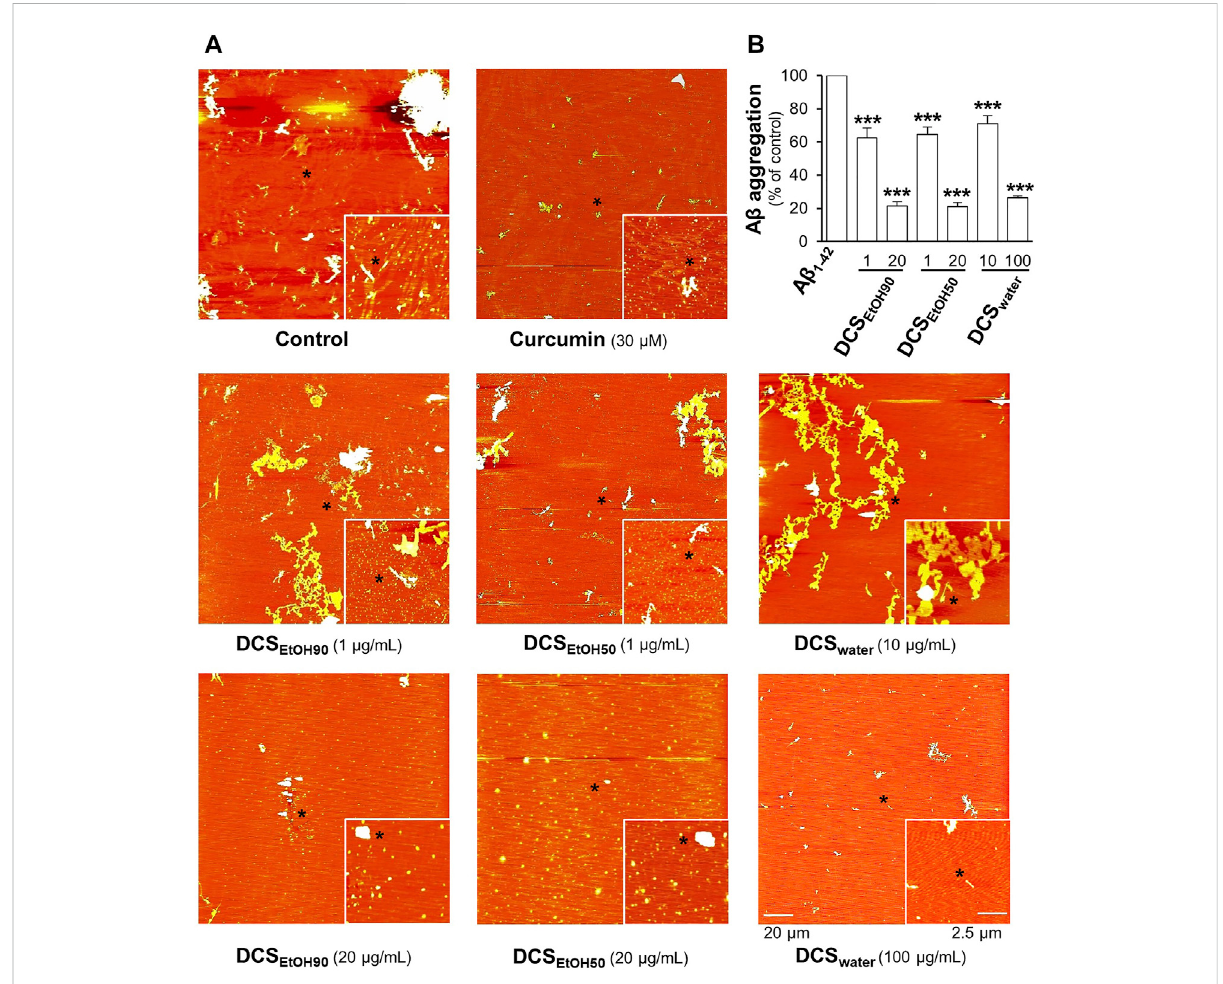
FIGURE 4 D. cochinchinensis stemwood extracts disassemble A β aggregation. A β